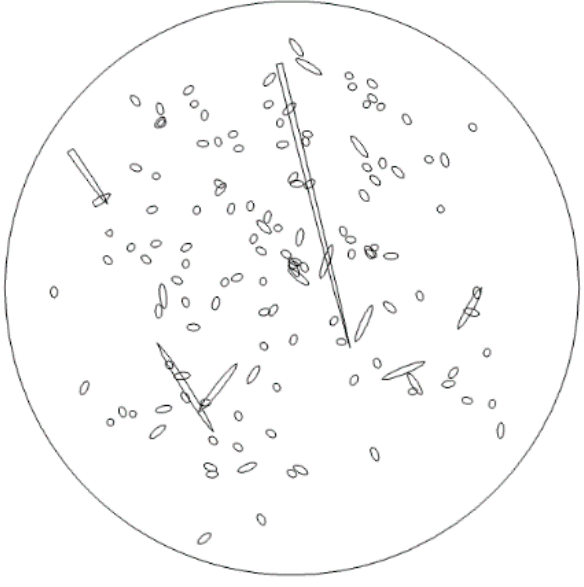
Figure 3. Simulated fiber dispersion through a section view at a 30 mm height.